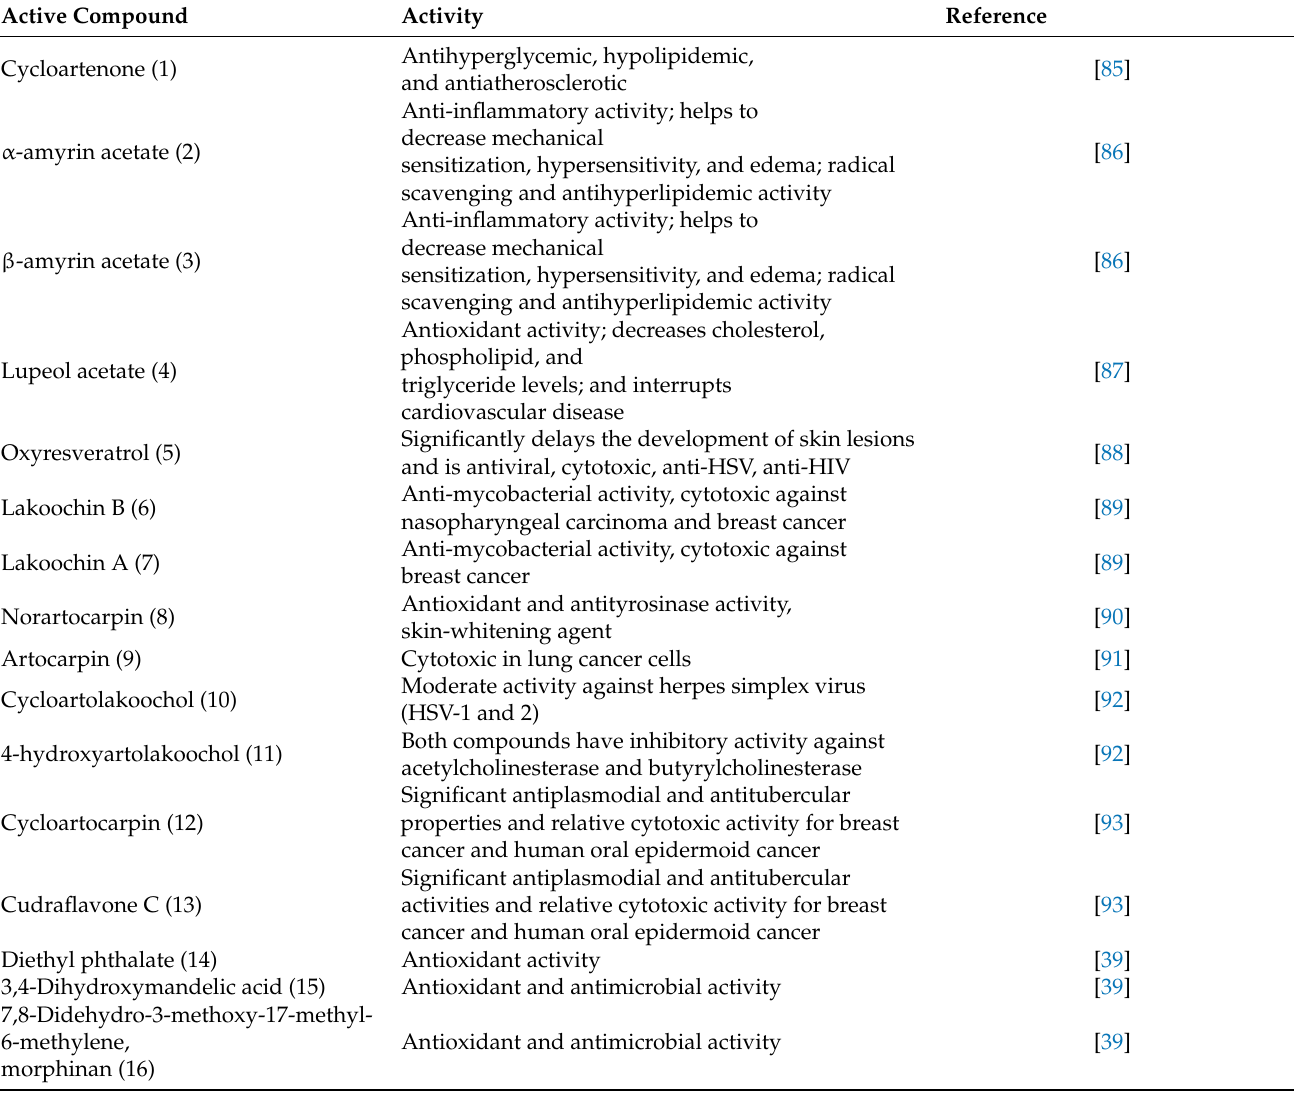
Table 5. Active compounds of A. lacucha based on scientific